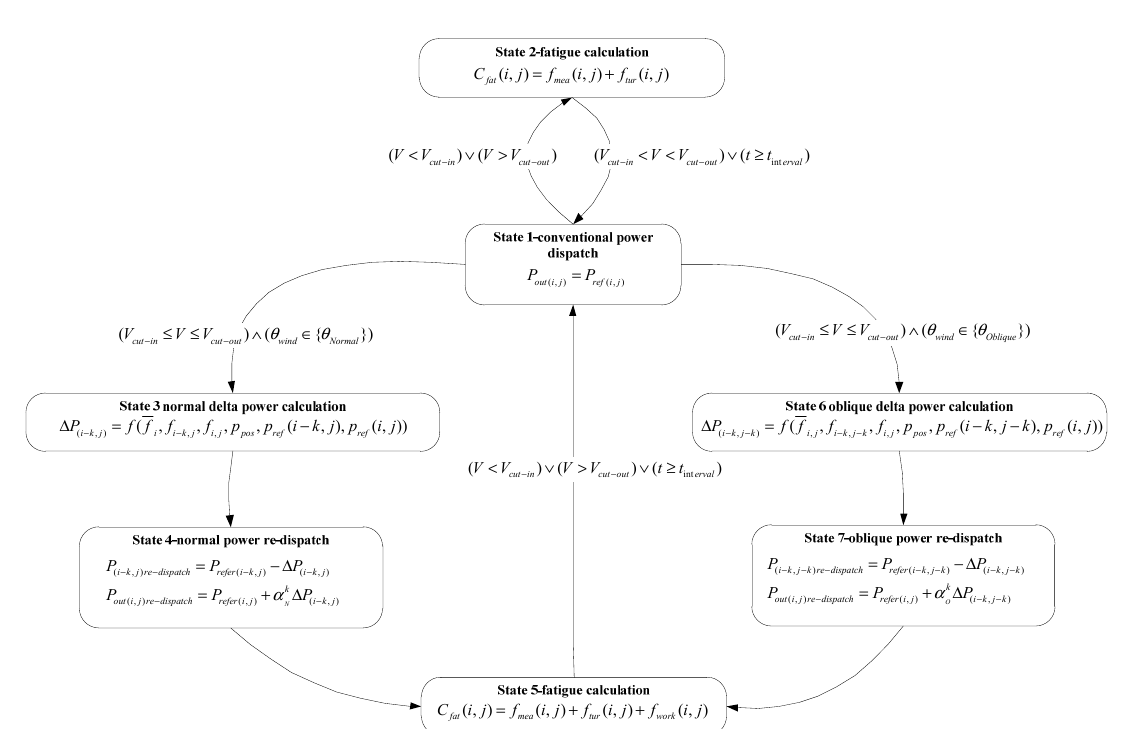
Figure 5. Improved control topology of the wind farm main controller.